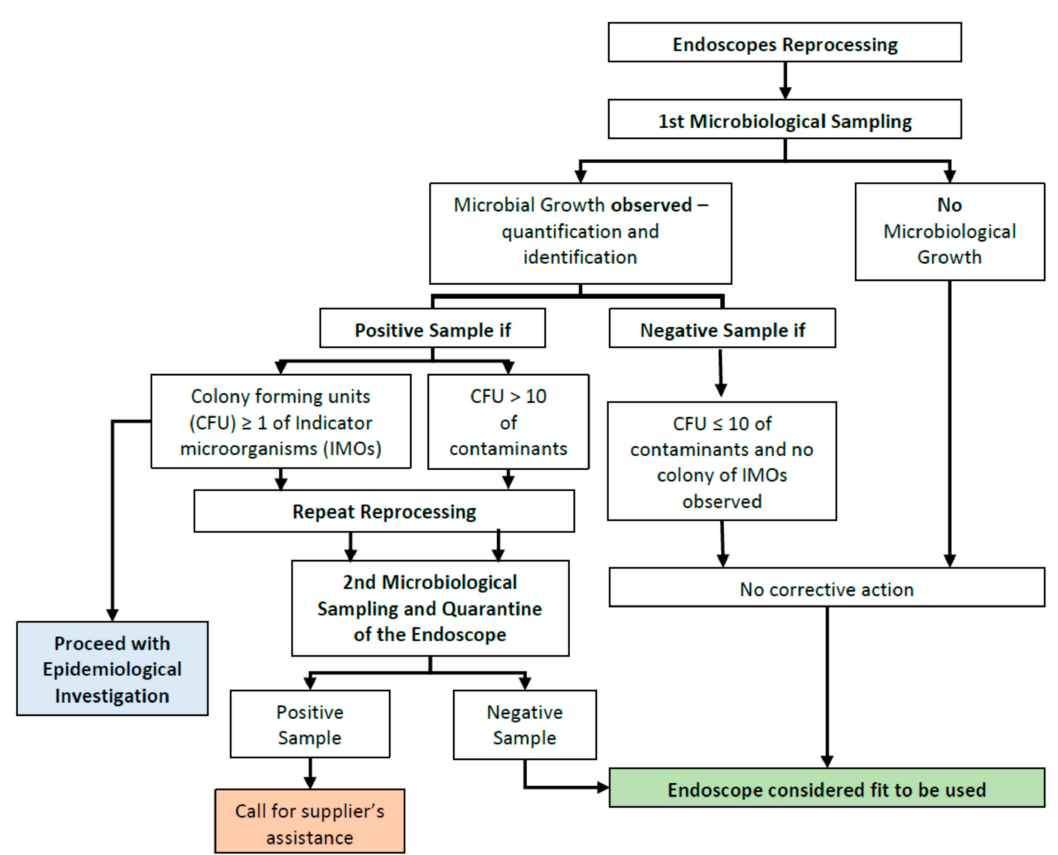
Figure 1. DScheme of actions and procedures to be followed after microbiological sampling of reprocessed endoscopes currently adopted at Istituto Mediterraneo per Trapianti e Terapie ad Alta Specializzazione